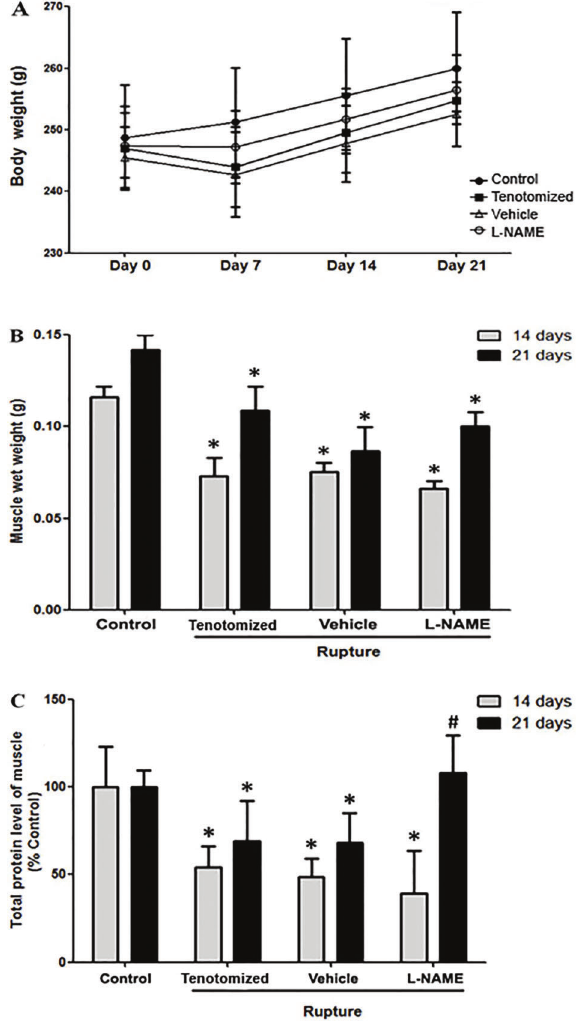
Figure 1. Effect of nitrergic inhibition on body weight, muscle wet weight and total protein levels of rats measured on days 14 and 21 after tenotomy. A , Body weight; no difference between groups was observed. B , Effect of nitrergic inhibition on soleus wet weight. C , Total protein levels of muscle normalized per muscle wet weight and the values are reported as percent of control. Data are reported as means ± SD for n=4 (control) or n=6 rats (all other groups). *P o 0.05 vs respective controls. # P o 0.05 vs tenotomized and vehicle on day 21 after tenotomy